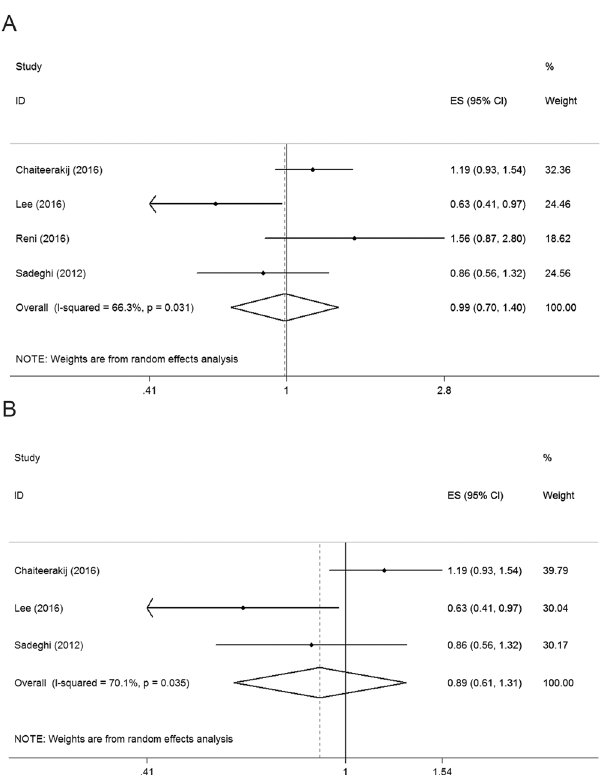
Figure 4. Forest plot for survival in patients at metastatic stage ( A ) with RCT, ( B ) without